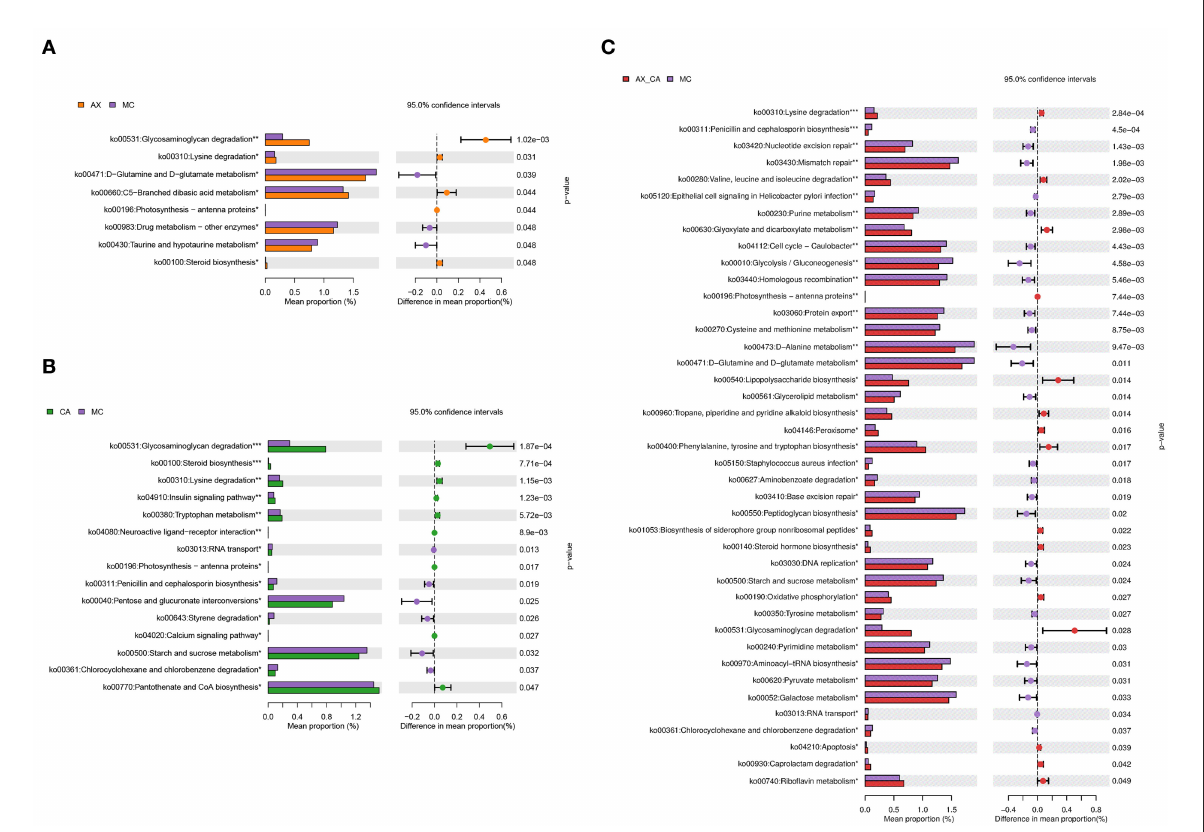
FIGURE7 Biological functions according to the differences in intestinal microbiota of mice in the AX (A) , CA (B) , and AX + CA (C) groups, compared to those of the DSS